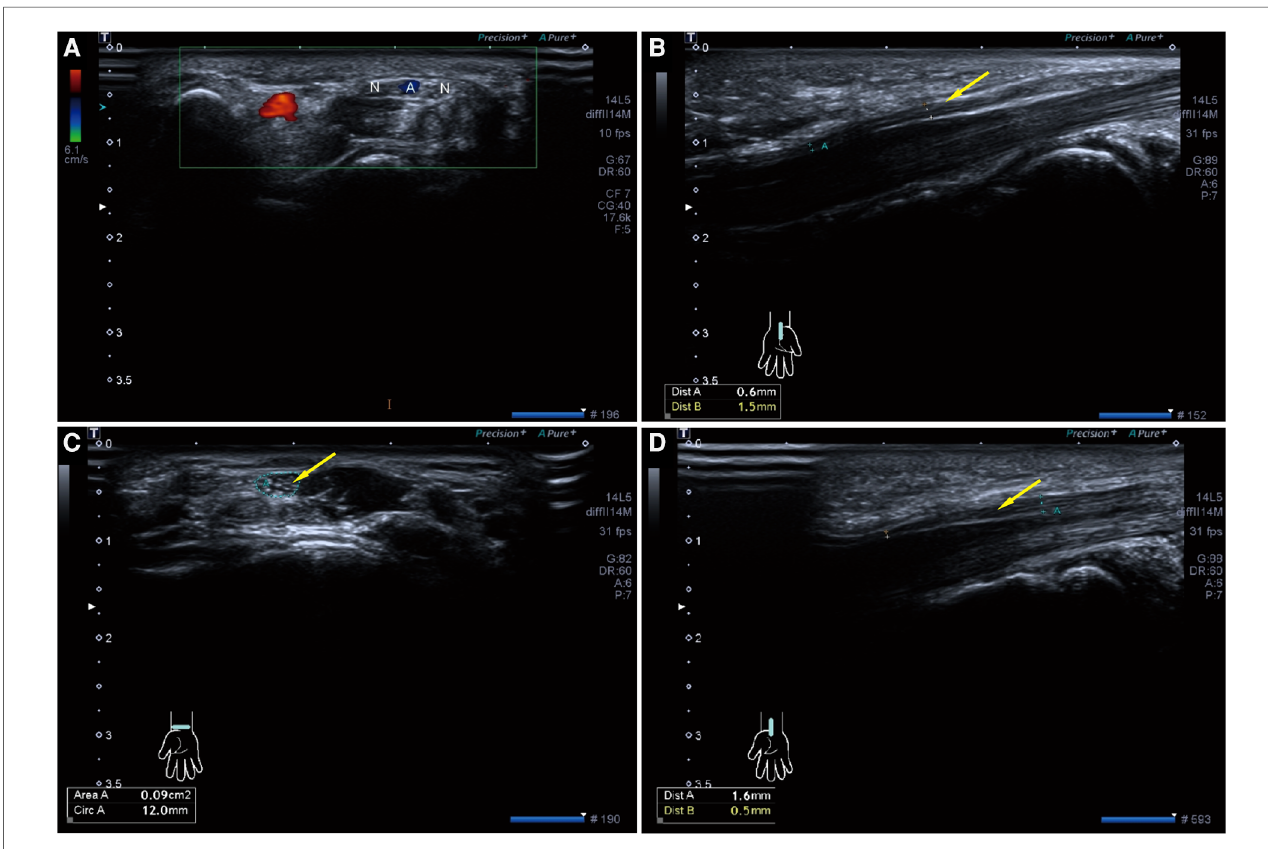
FIGURE 2 Preoperative high-resolution ultrasonography of both wrists. ( A ) Axial ultrasonography of left wrist shows bi fi d median nerve (N) with persistent median artery ( A,B ) Sagittal ultrasonography of left carpal tunnel shows the left median nerve (Yellow arrow) becomes signi fi cantly thinner after entering the carpal tunnel. ( C,D ) Axial and Sagittal ultrasonography of right carpal tunnel also shows the right median nerve (Yellow arrow) becomes signi fi cantly thinner after entering the carpal tunnel.